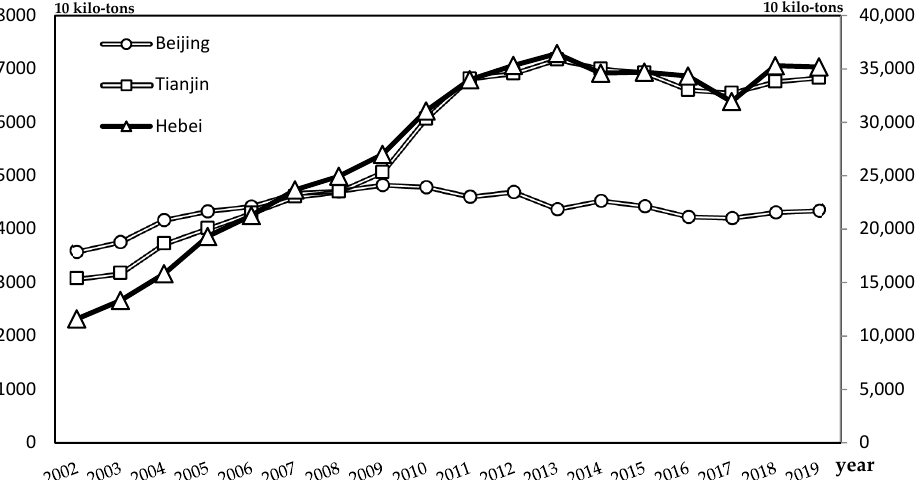
Figure 1. Changes in carbon emissions from UCL in Beijing, Tianjin and Hebei from 2002 to 2019.